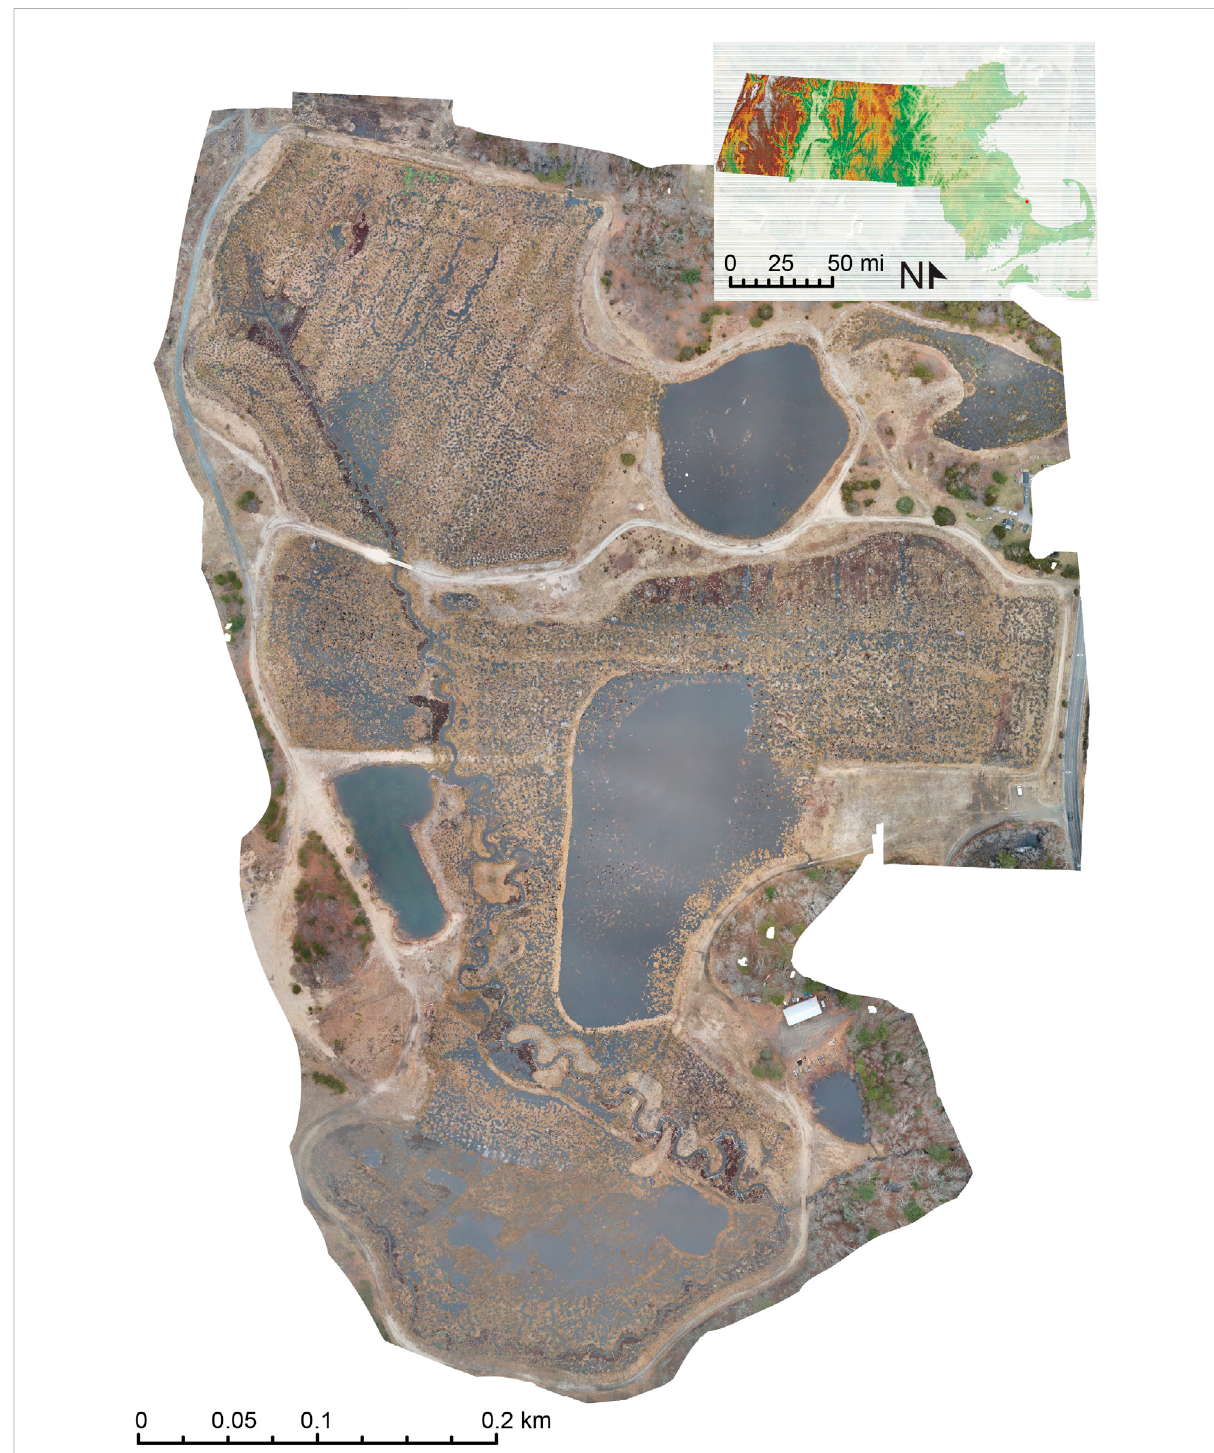
FIGURE 1 OrthomosaicimageofFoothills Preserve(from theUAS, fl own17March2022)(inset)LocationofFoothillsPreserveonadigital elevationmodel (DEM) from